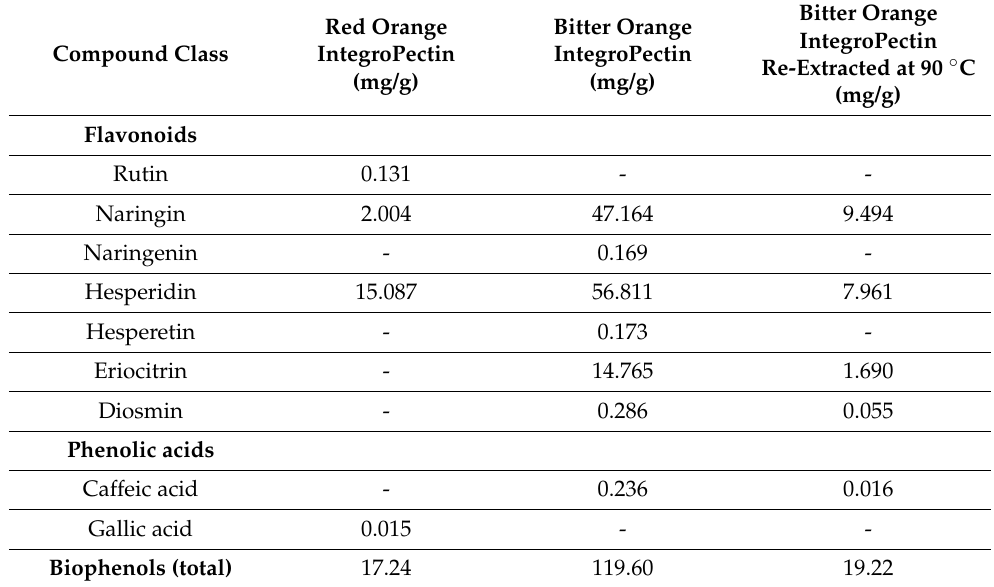
Table 3. Phenolic compounds in red orange IntegroPectin, bitter orange IntegroPectin, and bitter orange IntegroPectin re-extracted at 90 ◦